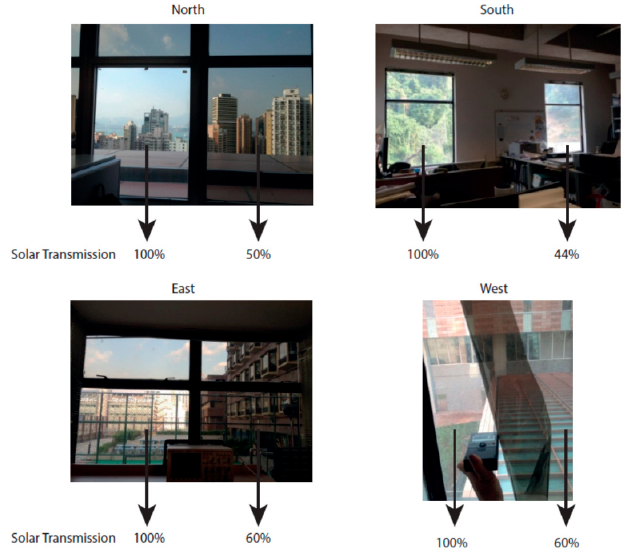
Figure 11. Solar transmission comparisons between windows with and without films.